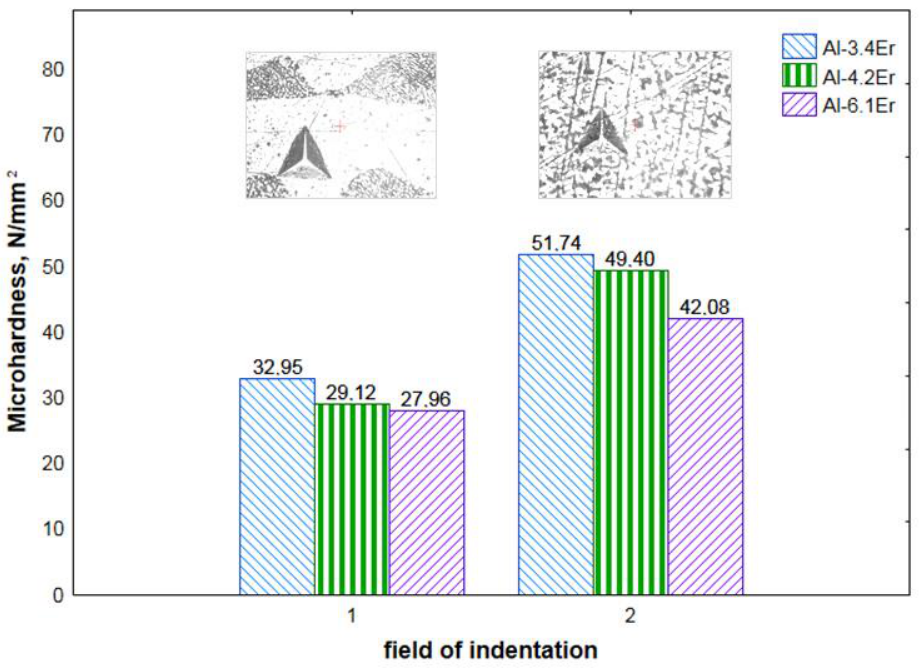
Figure 6. Histogram of the microhardness distribution over the indentation fields depending on the erbium content in the master alloy.